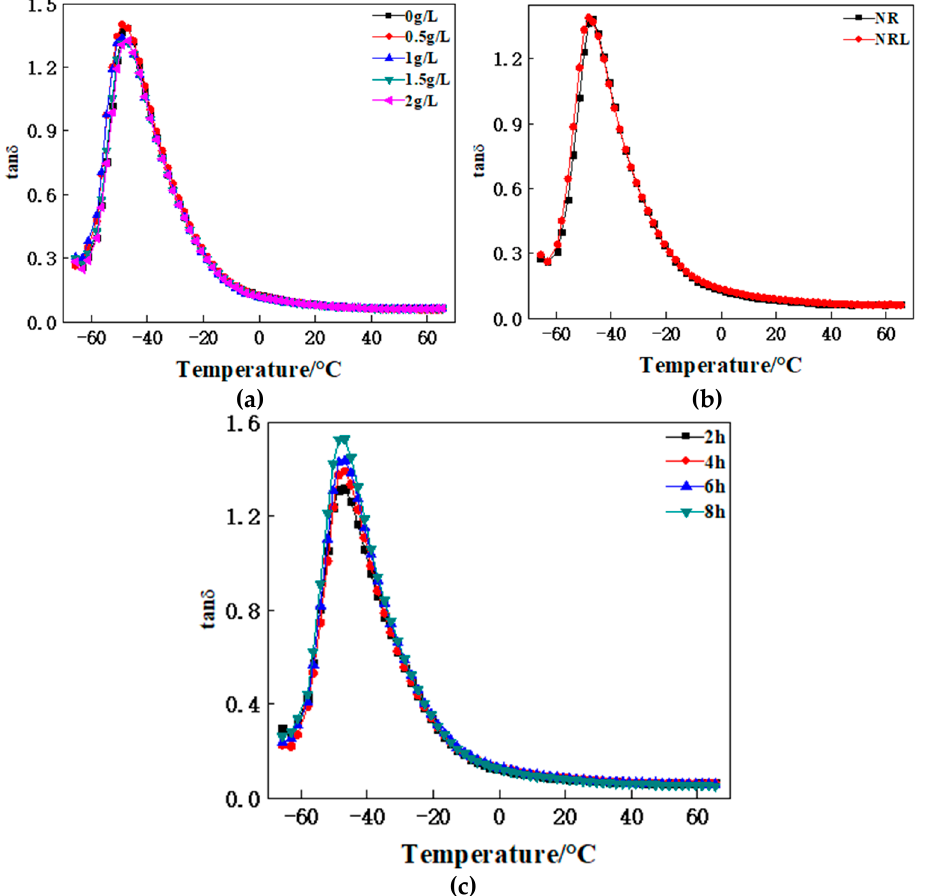
Figure 9. tan δ -T Curve of composites: ( a ) tan δ -T Curve of CF in natural rubber and natural latex; ( b ) tan δ -T Curve composites of CF modified by different concentration of dopamine; ( c ) tan δ -T Curve of composites of CF modified by different processing time of dopamine.